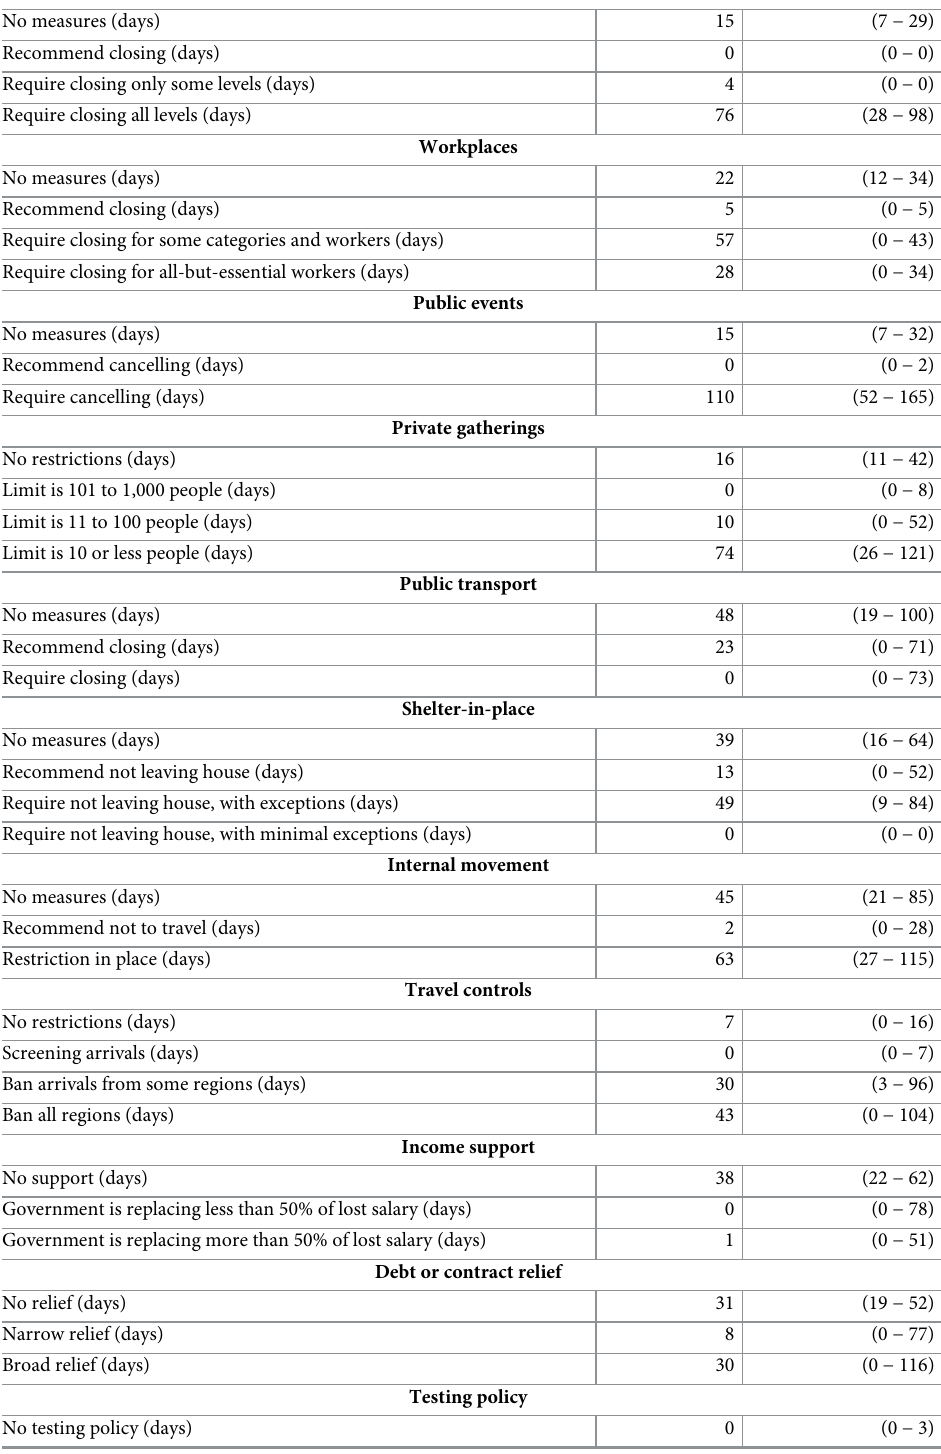
Table 1. Countermeasures in response to the COVID-19 pandemics. Values correspond to the number of days that the corresponding measure has being taken. For each countermeasure it is shown, at the peak of velocity on the coun- try, the median followed by first and third quartiles (calculated over the 211 countries considered in the